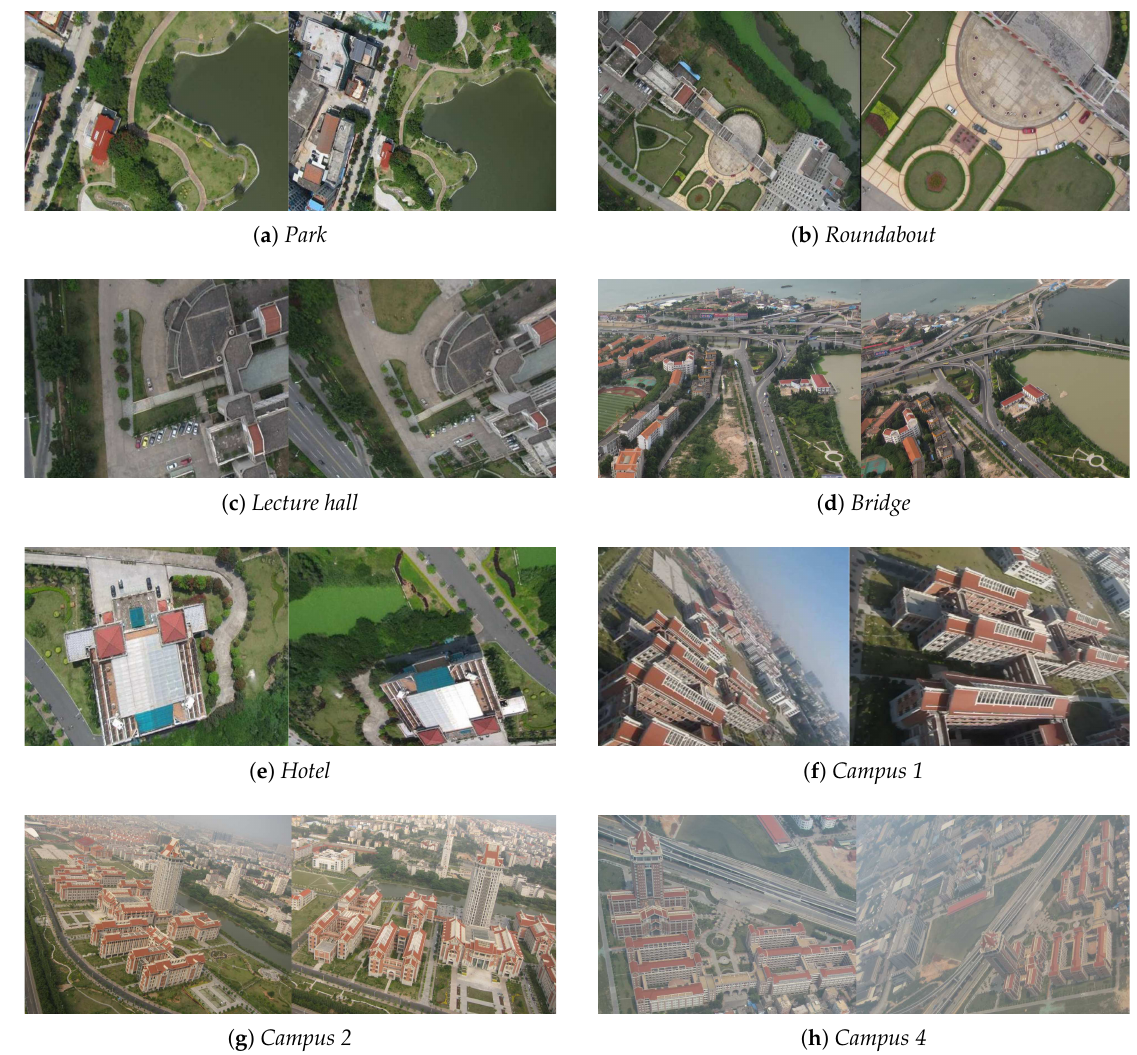
Figure 9. Low-altitude UAV ariel high resolution image